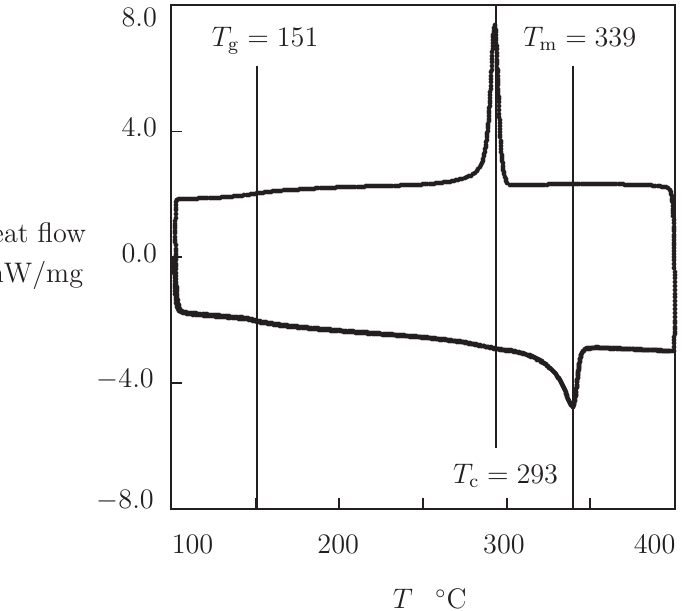
Figure 1. DSC thermogram of PEEK. Solid line: experimental data in DSC test with the heating and cooling rates of 20